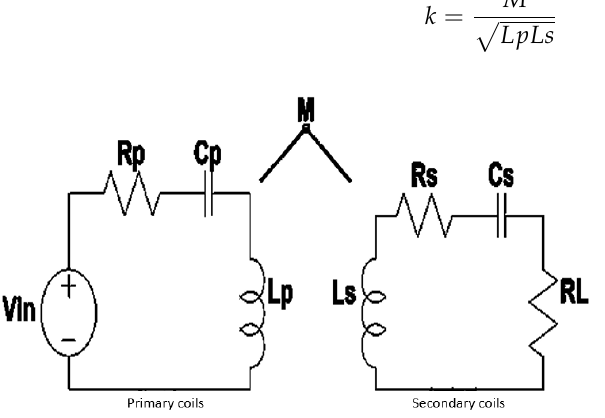
Figure 3. Mutual inductance of the primary and secondary